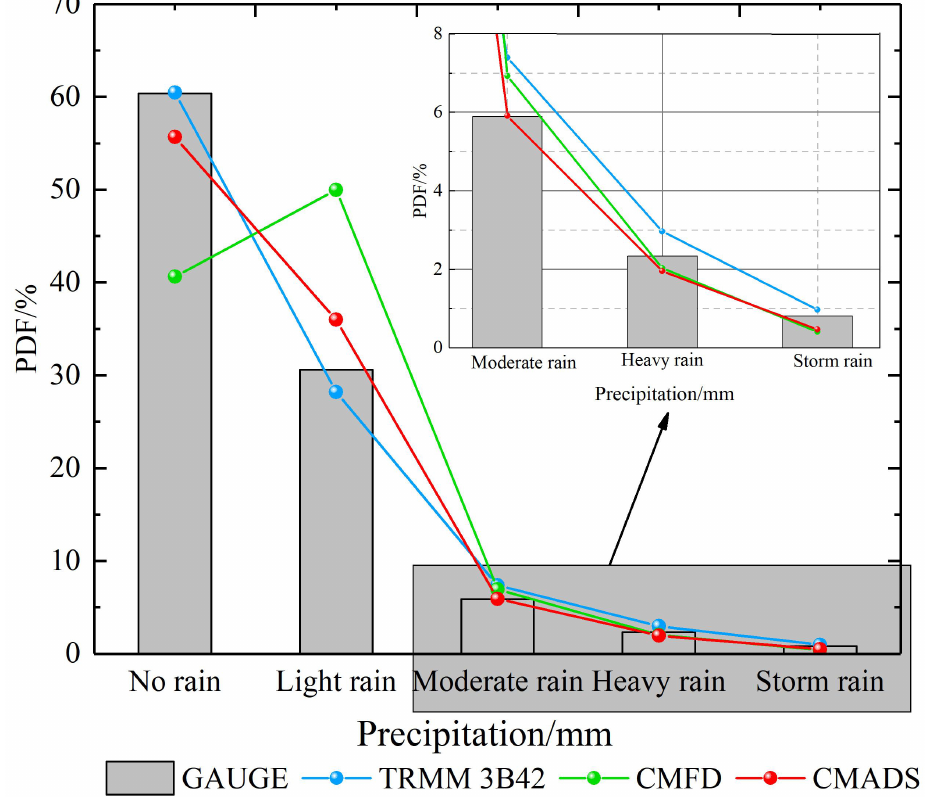
Figure 8. Frequency distribution of different precipitation intensities for different precipitation